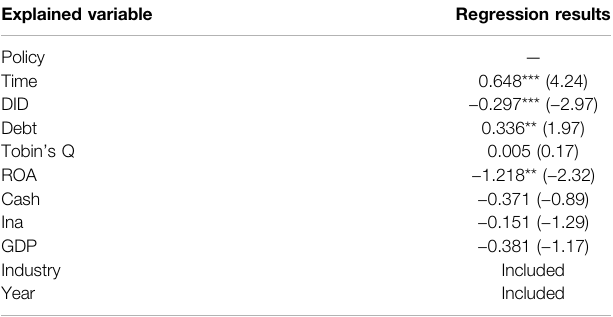
TABLE 3 | Benchmark regression